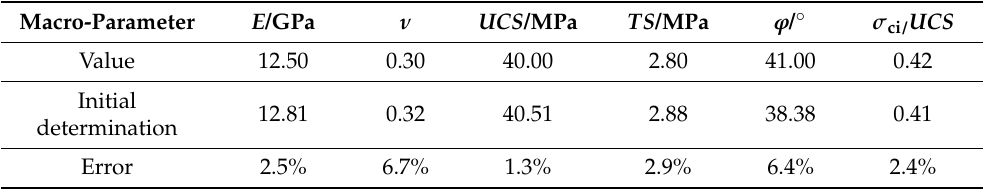
Table 7. Initial determination of microscopic parameters.